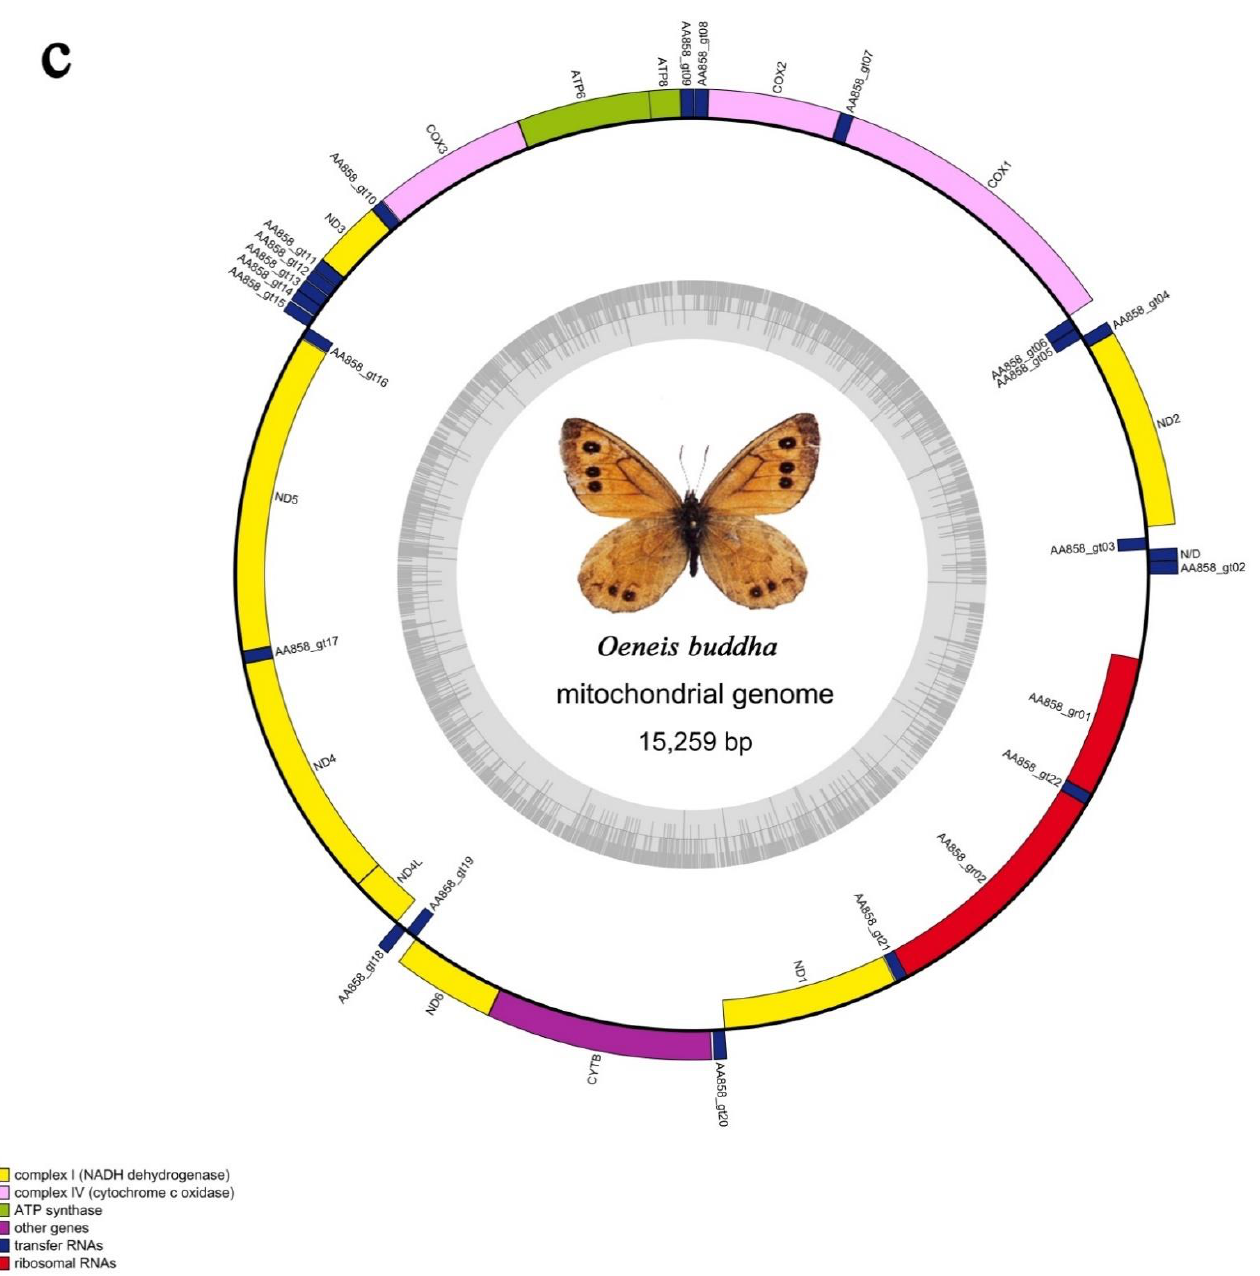
Figure 1. Mitochondrial gene map of three satyrid . ( a ) Hipparchia autonoe , ( b ) Paroeneis palaearctica , and ( c ) Oeneis buddha . The A + T contents in the three satyrid mitogenomes were 79.1%, 78.2%, and 79.6%, which were significantly higher than those of G+C and had obvious AT-bias (Table S2). On the whole, the A + T content in each gene component showed a decreasing trend as follows: A + T-rich region > rRNA > tRNA > PCGs. The AT skews of the mitogenomes were − 0.017, − 0.022, and − 0.029, respectively, whereas the AT skew of the PCGs and the first, second, and third codons were all negative, indicating that the T content is higher than that of A (Table 1). The AT skew values of all three mitogenomes were both within the corresponding values of other Satyrinae species, ranging from − 0.055 in Neope muirheadii to − 0.017 in H. autonoe (Table